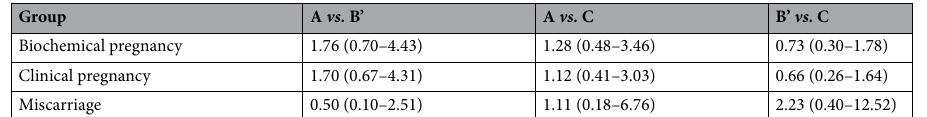
Group A vs. B’ A vs. C B’ vs.